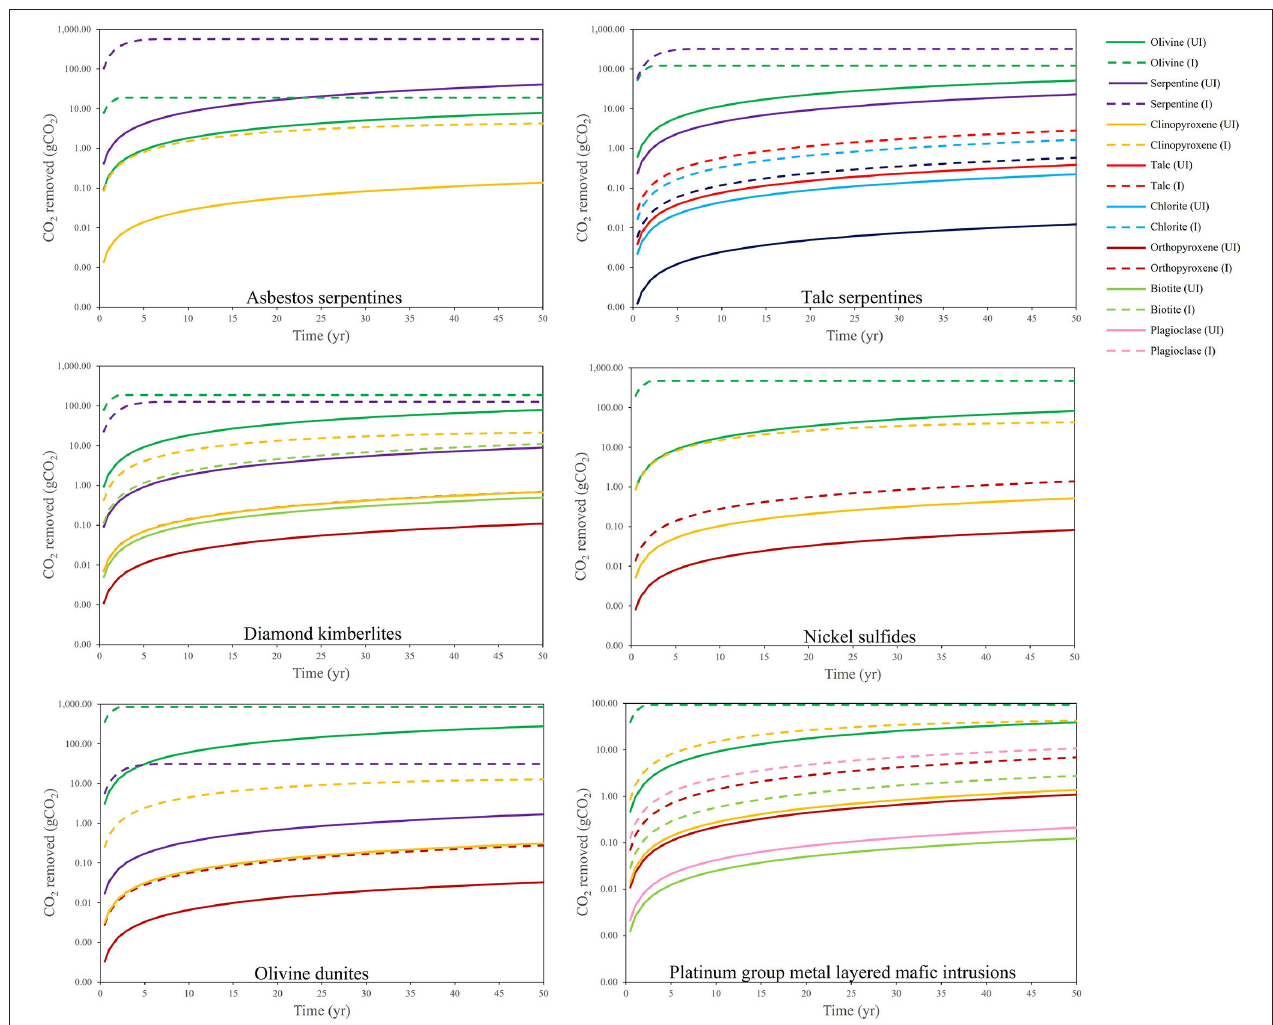
FIGURE 2 | CO 2 removal potential by enhanced weathering of a theoretical 1kg of different mine tailings materials over a 50 yr time period, modeled using a shrinking core model. Minerals typically contained within each tailings material are shown (abundance based on modal mineralogy, with non-reactive or untargeted minerals not included) under unimproved (UI) (pH of 6–8, and common grain sizes for these materials, e.g., 75 µ m for PGM tailings) and improved (I) (pH of 3–4, and grain sizes of 10 µ m for all types) (Bullock et al.,